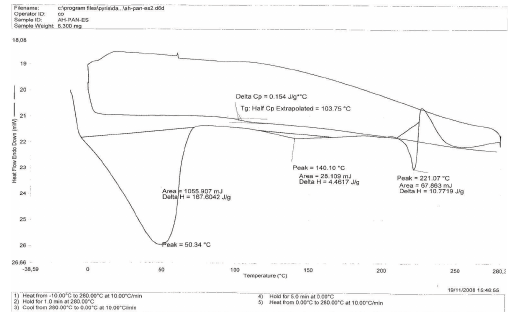
Figure 9: DSC curve of the PANI-ES composite obtained in nitro- gen atmosphere at heating rate of 10 ◦ C/min.